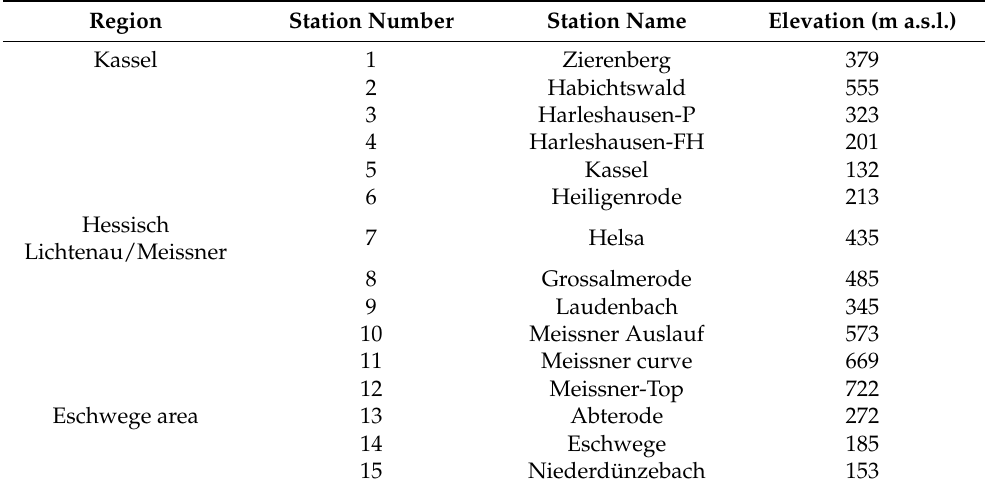
Table 1. Details of the precipitation collection stations and their relevant elevations and regions. Region Station Number Station Name Elevation (m